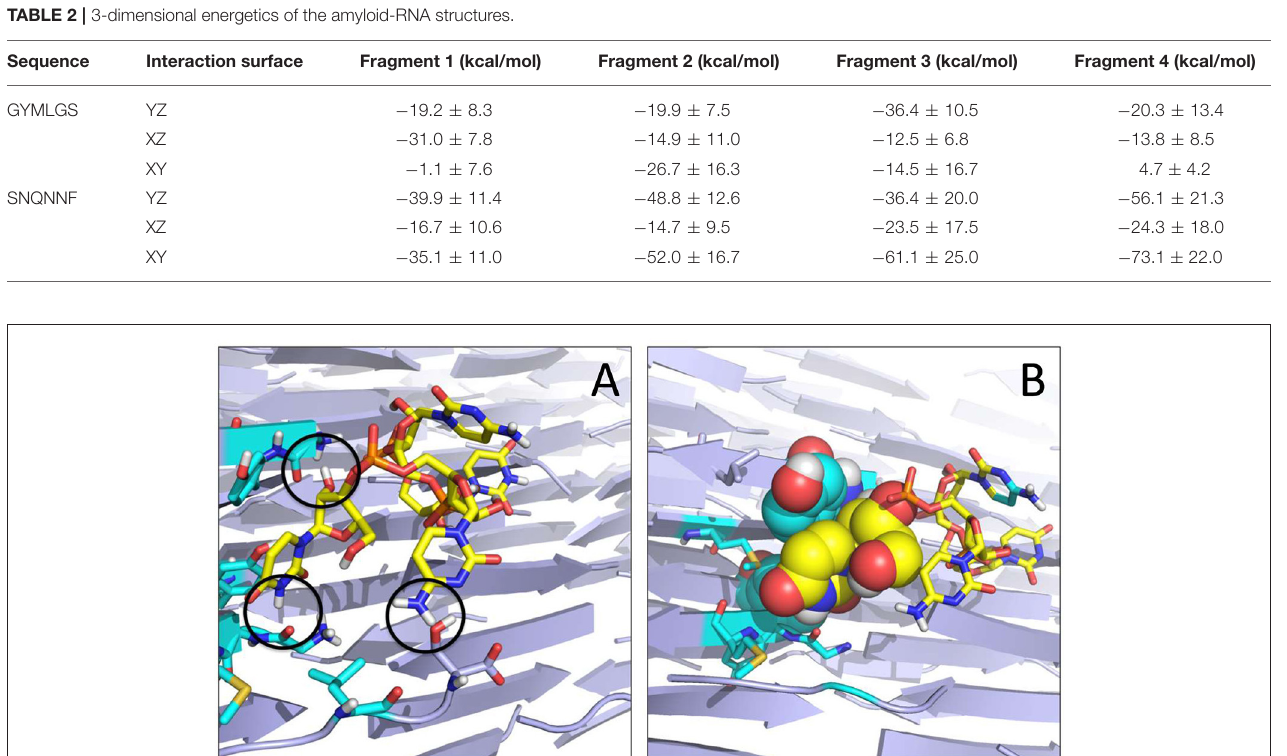
the nucleobases can establish H-bonding interactions with the backbone groups displayed on the surface, favored also by the polarity of the exposed N side chains ( Figure 5